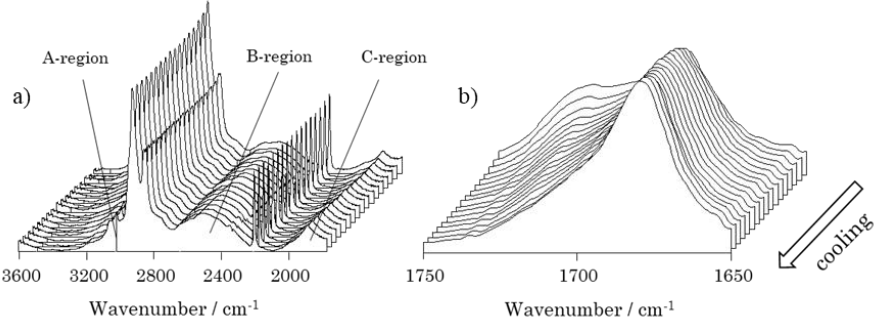
10 of 16 Figure 7. Dependence of phase behaviour of the CB6OBA: n OS on the length of the terminal alkyl chain, n , where ○ represents T N*I , ◼ T SmAN , ⯅ T SmAbSmA , ◆ T NTBN, ● T SmCNTB and ✕ T SmXSmC/Ab. Resonant X-ray diffraction was used to study the phases formed by the CB6OBA:4OS mixture. A resonant signal at the carbon edge is visible in the temperature range of the N TB phase, but was too weak to measure accurately. This resonant signal associated with the helix in the N TB phase does not appear to be temperature-dependent, but becomes even weaker on further cooling and completely disappears on heating into the nematic phase. The transition to the SmC phase is precluded by crystallisation of the sample, and hence, we could not establish whether this smectic C phase is a